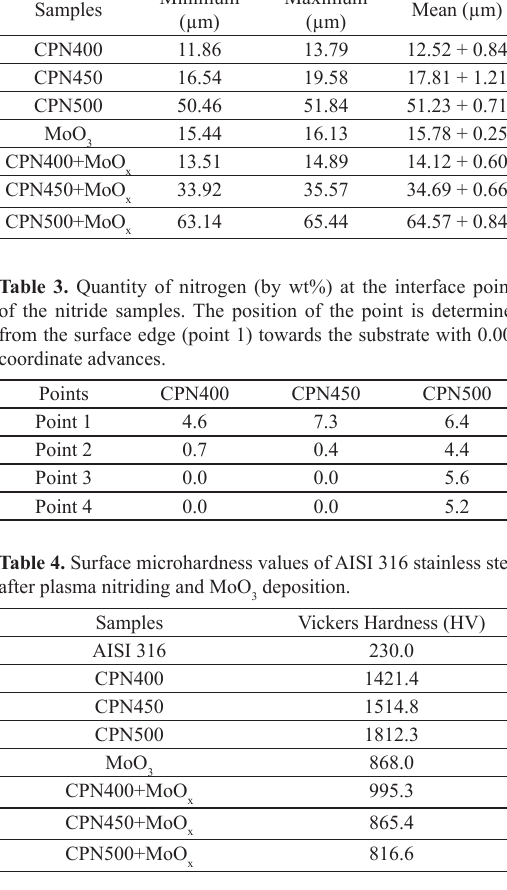
Figure 3. Line profile of CPN400+MoO